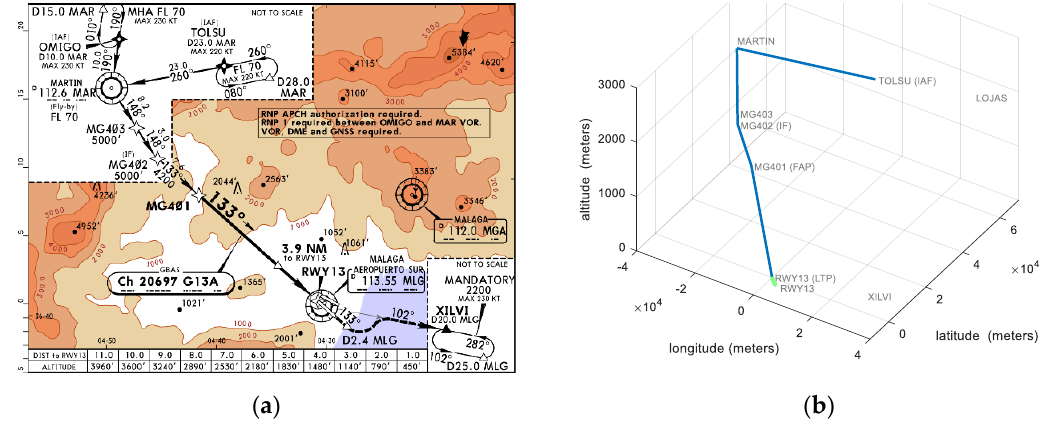
Figure 5. Approach chart ( a ) and 3D view ( b ) of the approach path.